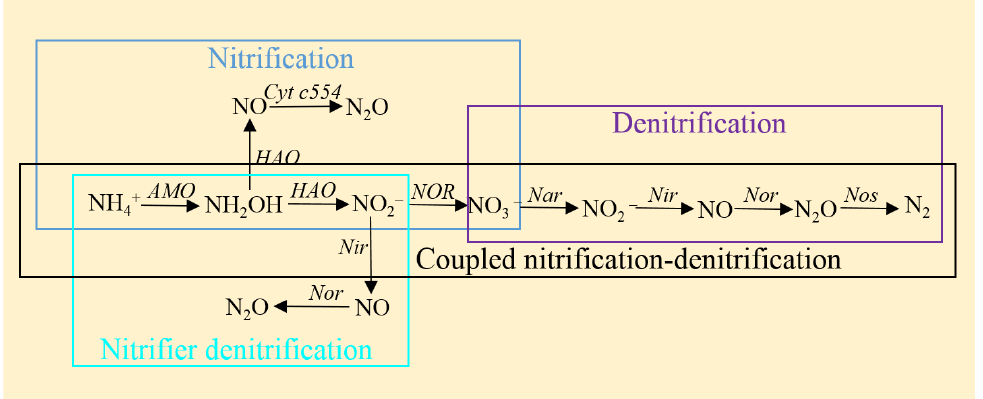
Figure 1. Main processes of N 2 O production in aquatic environments.